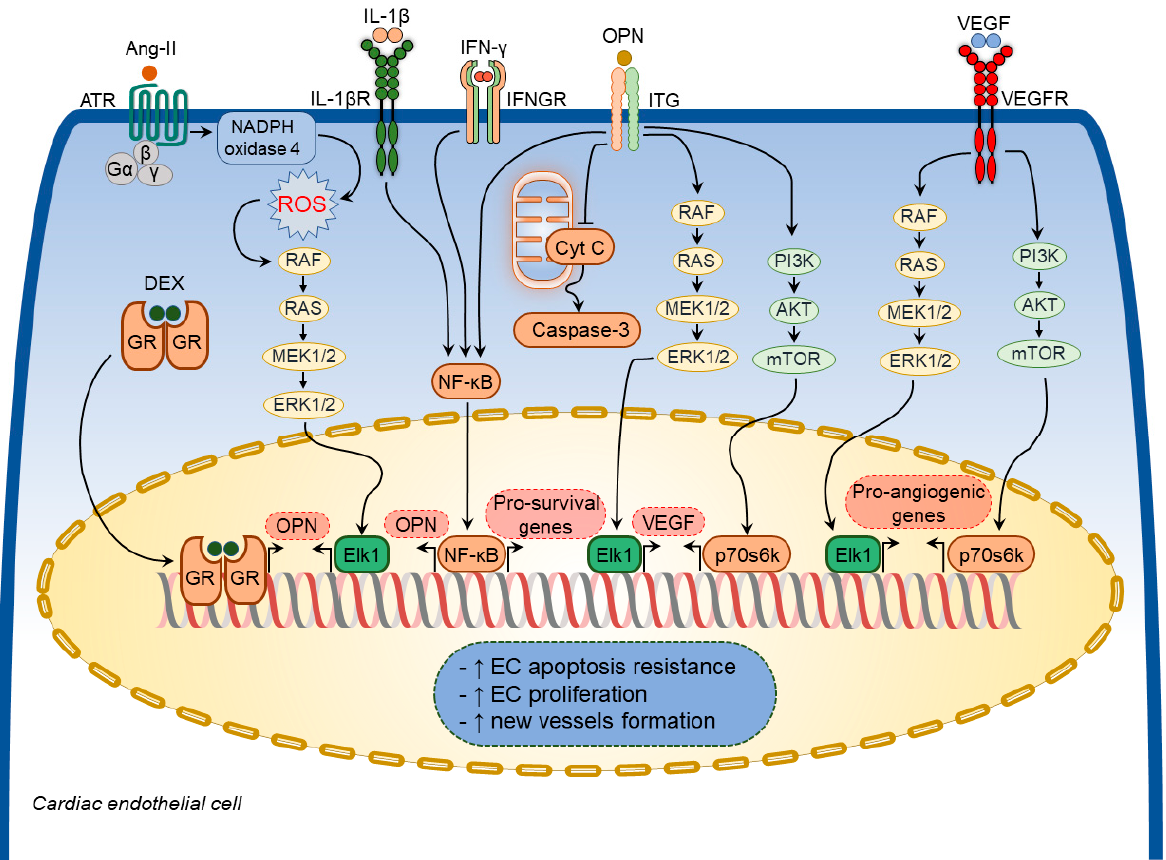
Figure 4. Osteopontin signaling in cardiac endothelial cells. A number of factors induce osteopontin (OPN) expression in cardiac endothelial cells including angiotensin-II (Ang-II), interleukin-1 β (IL- 1 β ), interferon- γ (IFN- γ ), and dexamethasone (DEX). In turn, osteopontin regulates several cellular processes in cardiac endothelial cells via modulating certain signaling pathways. These pathways include osteopontin-induced vascular endothelial growth factor (VEGF) expression and subsequent VEGF-mediated expression of pro-angiogenic factors, inhibition of cardiac endothelial cell apoptosis via blocking mitochondria-mediated apoptosis pathway. Osteopontin signaling in cardiac endothelial cells results in increased apoptosis resistance, increased cell proliferation, and new vessels formation.